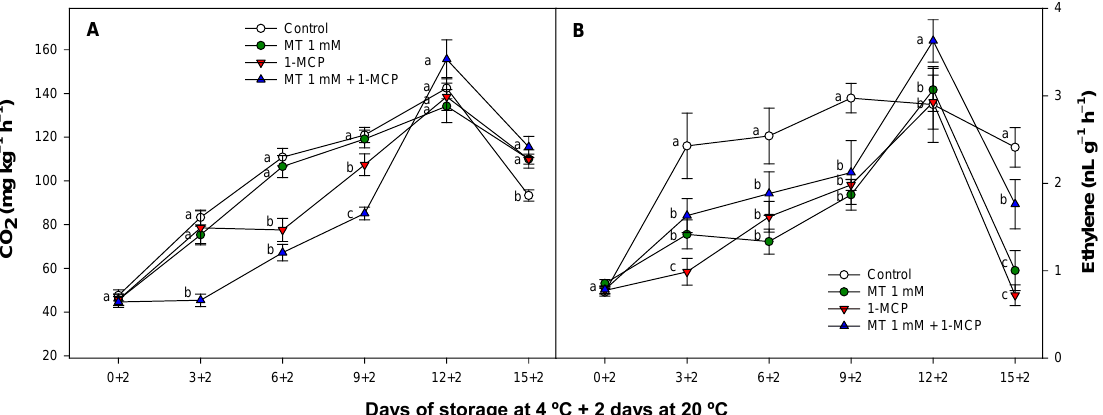
Figure 3. Respiration (mg CO 2 kg − 1 h − 1 ) ( A ) and ethylene production rates (nL g − 1 h − 1 ) ( B ) of ‘Cronos’ zucchini fruit treated with melatonin at 1 mM (MT) or distilled water (Control) with or without 1-MCP during cold storage and after cold storage plus 2 days at 20 °C. Data are the mean ± SE (n = 3). Different lowercase letters show significant differences ( p < 0.05) among treatments for each sampling date.